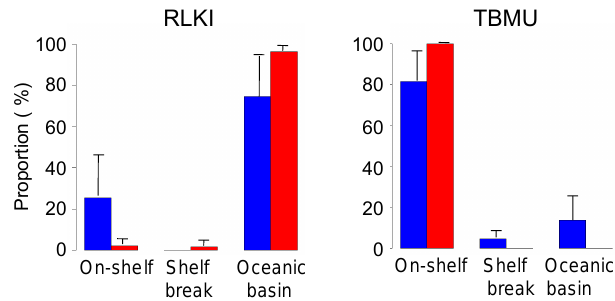
Figure 2. The marine habitats of on-water locations during the for- aging trips in red-legged kittiwakes (RLKI) and thick-billed mur- res (TBMU): on-shelf (0–200m bottom depth), shelf break (200– 1000m bottom depth), and oceanic basin (>1000m bottom depth). Red bars represent 2013 and blue bars in 2014 (the mean and stan- dard